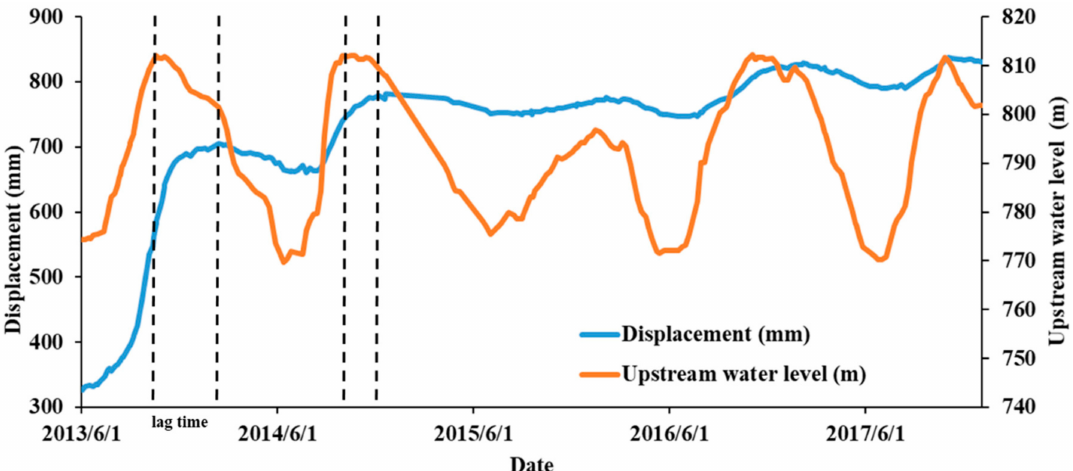
Figure 9. Correlation diagram of displacement and water level changes. The water level change was proportional to the change of the displacement. There is lag time between reservoir level fluctuations and